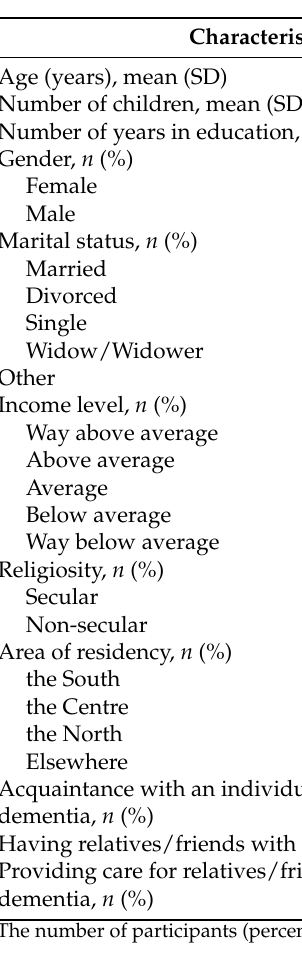
Table 1. Characteristics of the